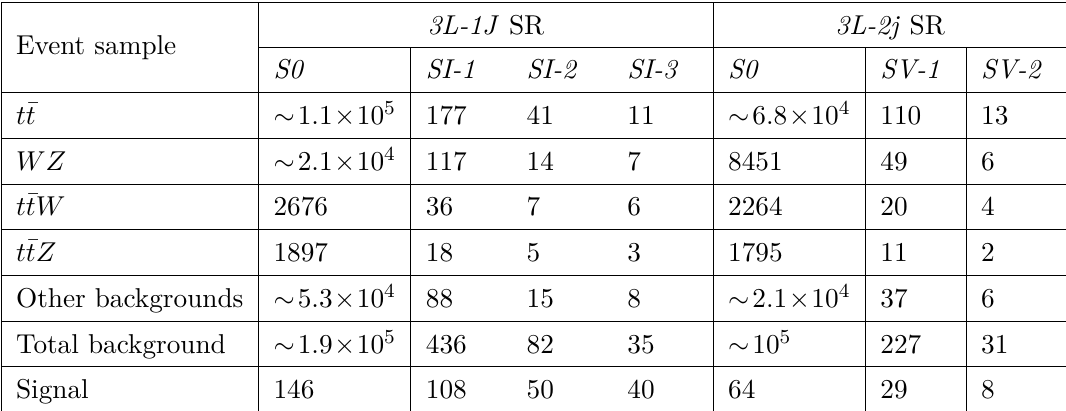
Figure 7 . Normalised kinematic distributions for 3L-2j events for BP1 in Model- 3 F and M (right) distributions for events satisfying SI-1 . jj